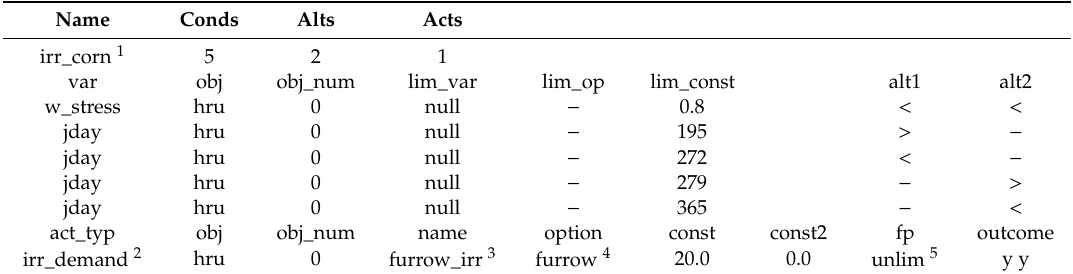
Table 5. Decision table for irrigation application in SWAT + for the rainfed maize to irrigated mixed crops to irrigated mixed crops